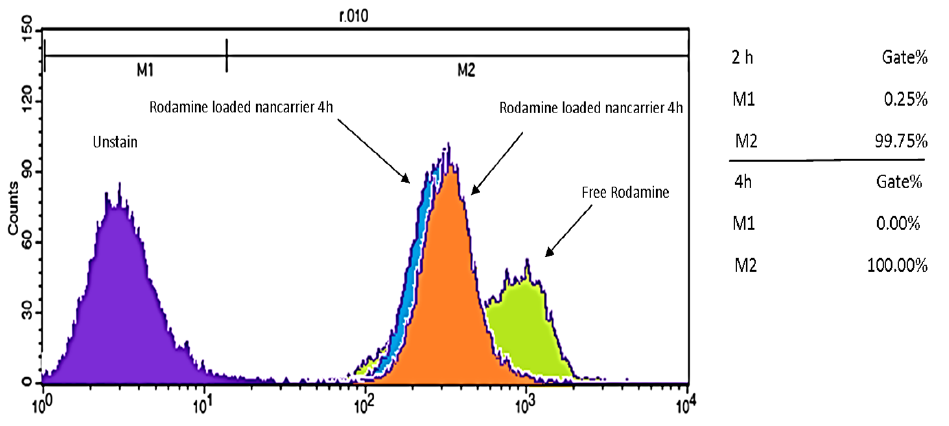
Figure 3: Cellular uptake as a percentage of DOX-nanocarrier by MCF-7 cells, 2 and 4 hours after treatment.